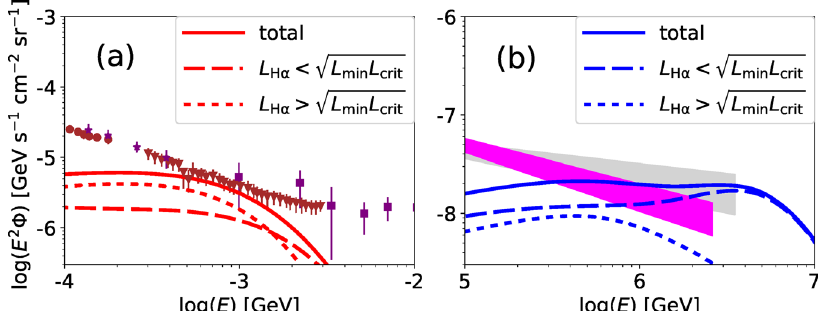
Fig. 4 Contributions by relatively luminous and faint LLAGN. a Diffuse soft gamma-ray intensities from relatively luminous (dotted) and faint (dashed) LLAGN. The solid line shows the sum of these. Data points are provided by Swift BAT 115 (brown-circle; 1- σ errors for systematic and statistical errors), SMM 116 (brown-triangle; de fi nition of errors are not available), Nagoya-baloon 117 (purple-star; de fi nition of errors are not available), COMPTEL 2 (purple- square; 2- σ error bars for the linear sum of the systematic and statistical errors). b Same as ( a ) but for diffuse neutrino intensities. Data are provided by IceCube 4,118 (lightgrey and magenta regions; 68% con fi dence levels).